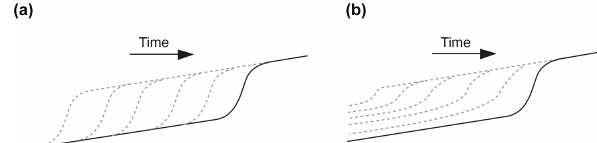
Figure 13. Sketches illustrating the difference in the geometry of successive longitudinal profiles following the retreat of a knickpoint depending on whether fluvial incision is inhibited (a) or not (b) downstream of the retreating knickpoint with respect to the con- tinuously falling base level.